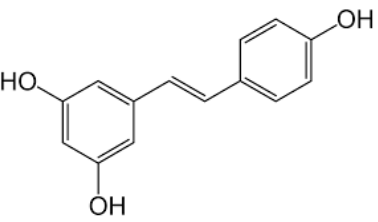
Figure 2. The chemical structure of resveratrol. A polyphenol commonly found in various plant food such as berries and wines